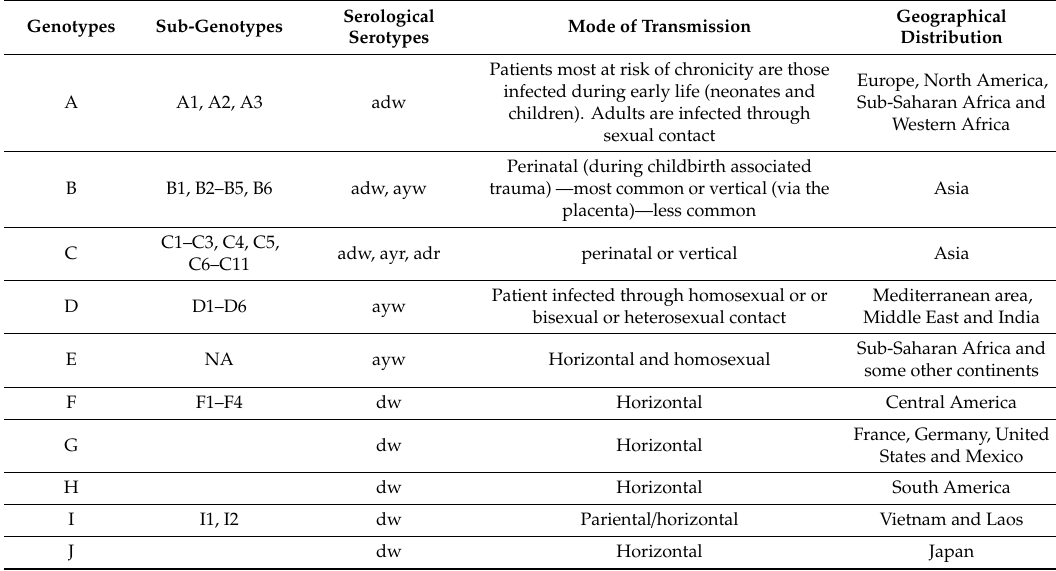
Table 1. Characteristic features of HBV genotypes, sub genotypes and geographical